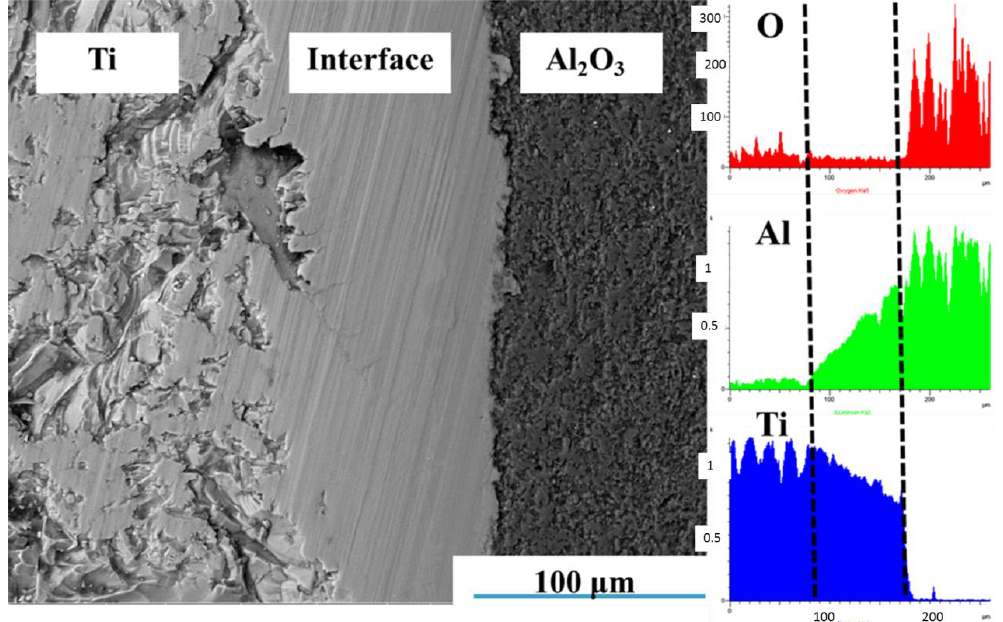
Figure 4. SEM images and line scanning analysis of the interface at 1400 °C holding for 1.5 h.